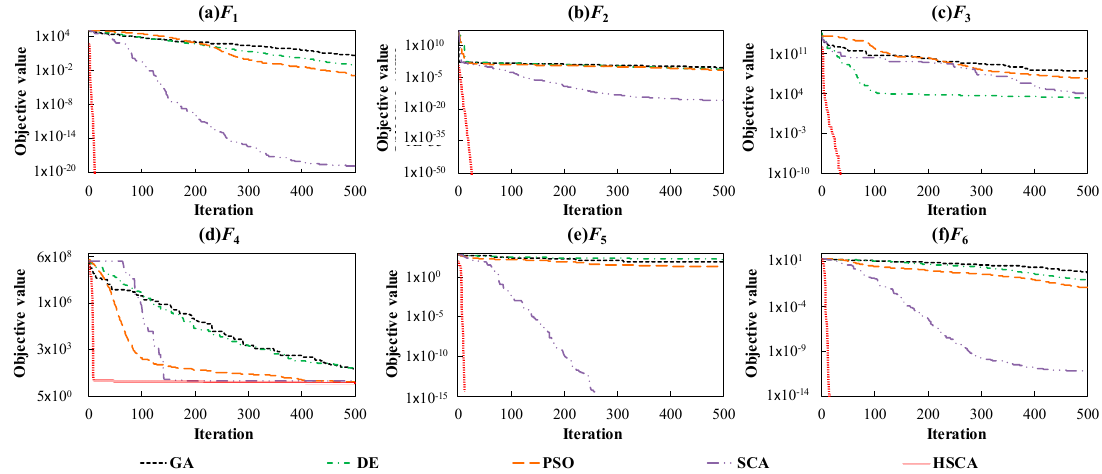
Figure 4. Convergence trajectories of different methods for test functions in 40 variables. ( a ) F 1 ; ( b ) F 2 ; ( c ) F 3 ; ( d ) F 4 ; ( e ) F 5 ; ( f ) F 6 . Table 3. Experimental results of different methods for test functions in 40 variables.